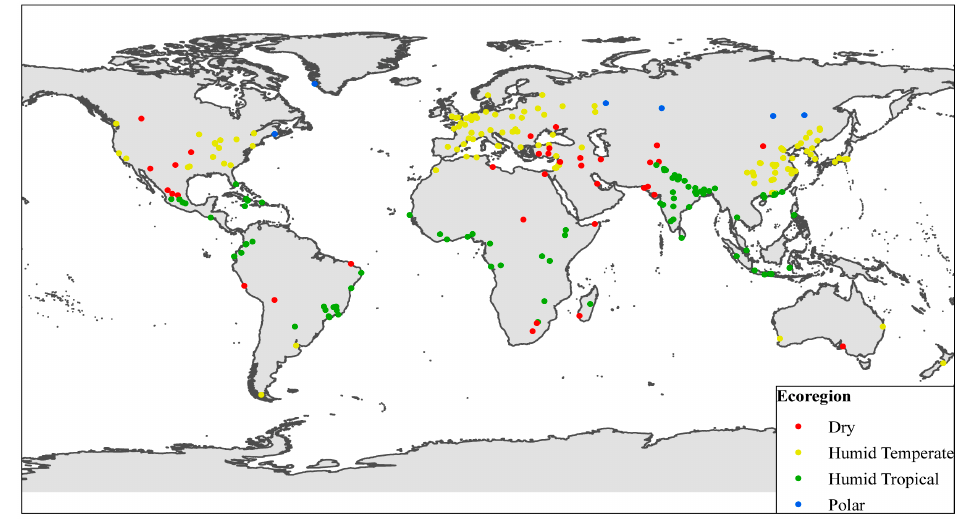
Figure 1. Geographical distribution of SHUE cities and their classification with regard to ecoregion domain.